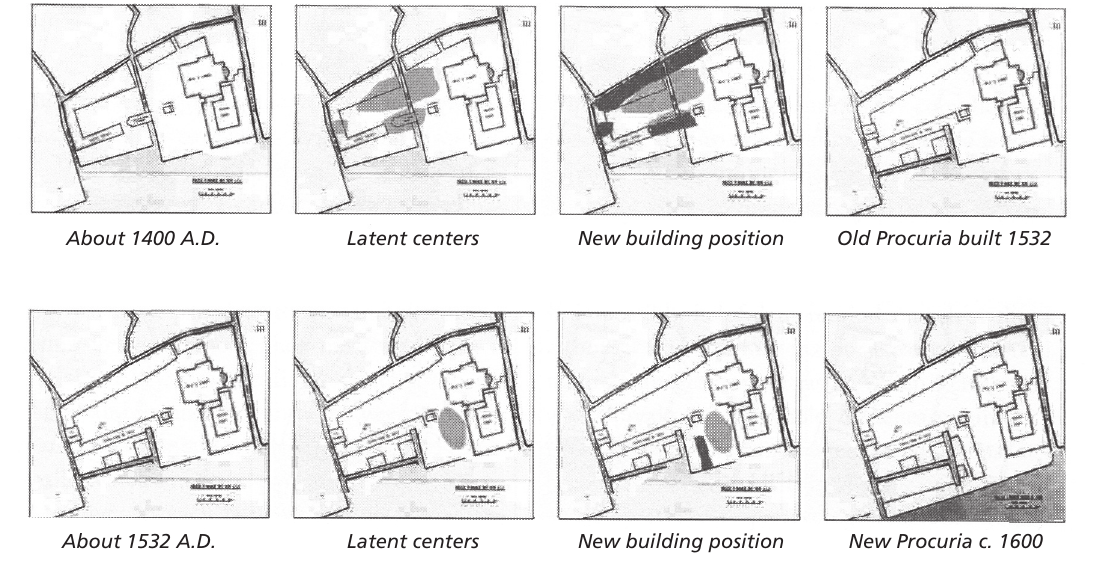
Figure 17. Evolution of St. Mark’s Square over Time. Source: { Nature of Order Book Two}